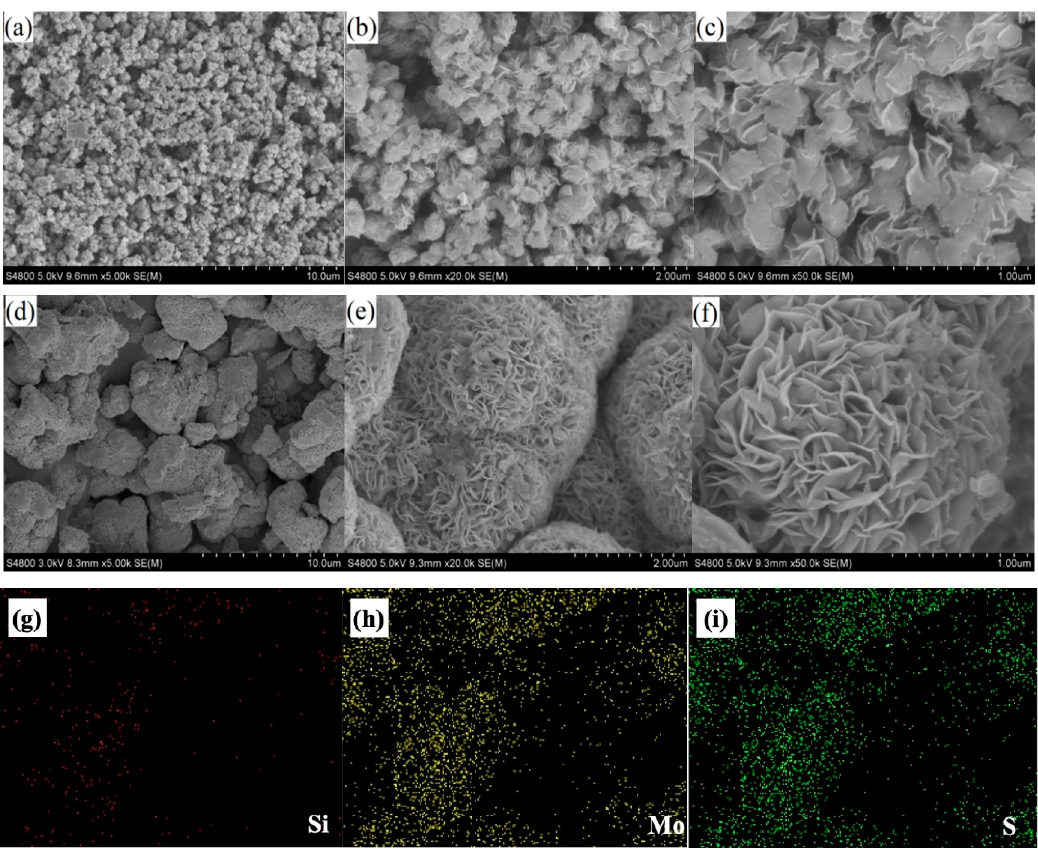
Figure 3. SEM images of MoS 2 ( a–c ), S and Si/MoS 2 composite ( d–f ), and EDX elemental mapping image of Si ( g ), Mo ( h ), and S ( i ) in Si/MoS2 composite.